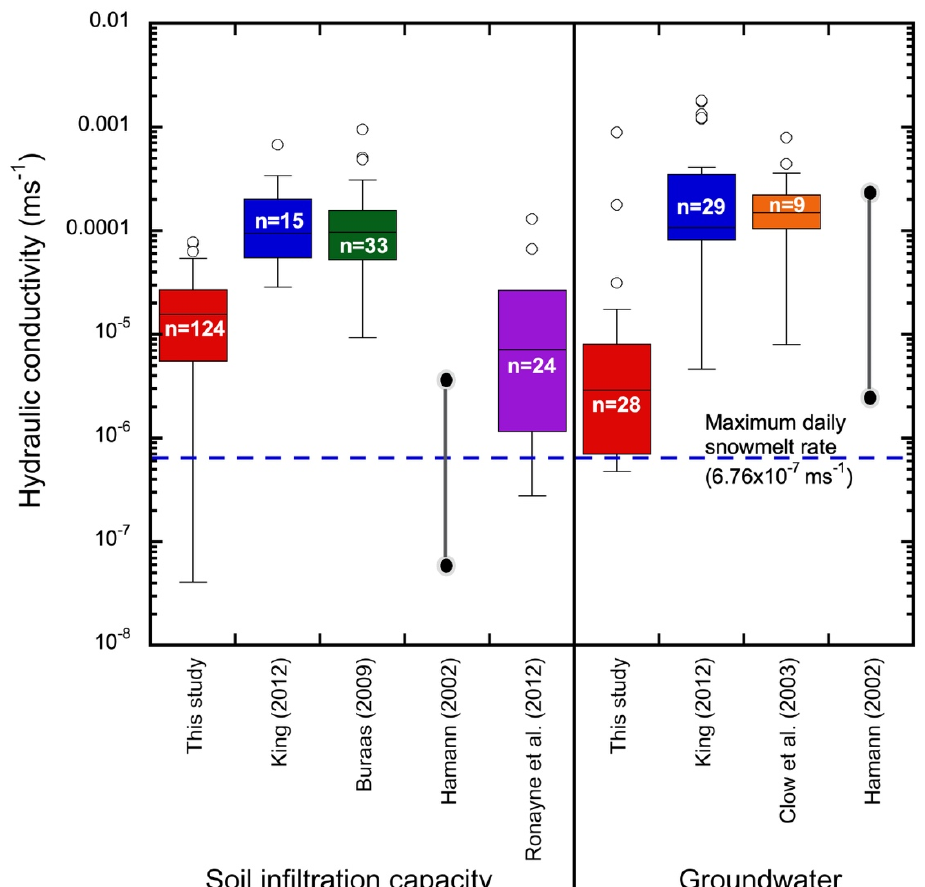
Figure 10. Summary statistics for saturated hydraulic conductivity (K) values from this study and other studies from Niwot Ridge and adjacent areas (see also [44]). Six extremely low soil hydraulic conductivities from this study were not plotted. The 28 groundwater values from this study plot the range in subalpine till calculated using the Hvorslev and Shapiro–Greene methods. Hamann [45] reported a range of values. The dashed line is the maximum daily snowmelt rate recorded at the C1 Snotel site from 1981 to 2016 (http://www.wcc.nrcs.usda.gov/nwcc/site?sitenum=663&state=co; accessed 1 November 2016).